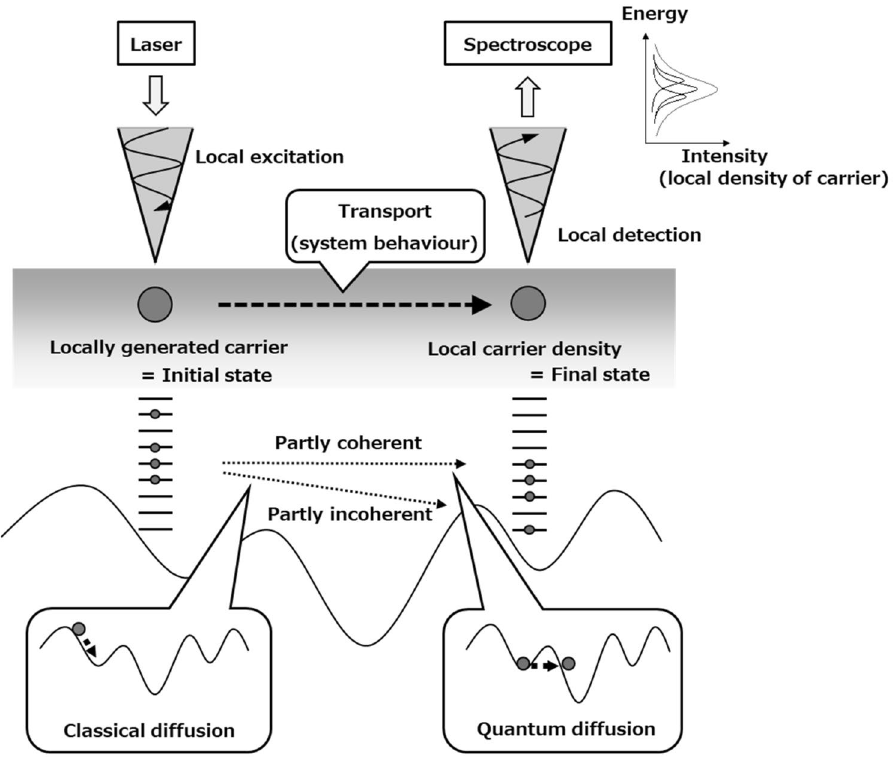
Figure 1. Schematic image of the theory of the two-probe measurement. Excited carriers generated by local excitation at arbitrary points using a sharpened probe diffuse in the sample. The detection of carriers